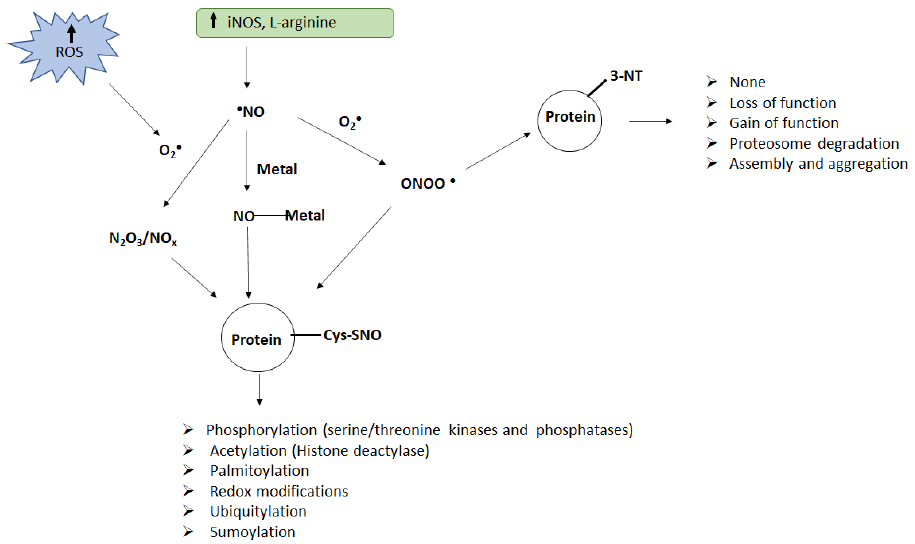
Figure 1. Schematic of protein nitration and nitrosylation and their consequences. Enhanced ROS generation and accumulation of nitric oxide can lead to the formation of peroxynitrite (ONOO − ), NO oxides (N 2 O 3 /NOx), or metal–NO complexes (M–NO), which act as nitrating agents in vivo. Peroxynitrite can induce nitration of tyrosine (Tyr) residues on the proteins while peroxynitrite, metal–NO complexes, or NO oxides can induce nitrosylation of cysteine (Cys) residues on the proteins. Both nitration and nitrosylation can alter protein function resulting in several adverse conse- quences.